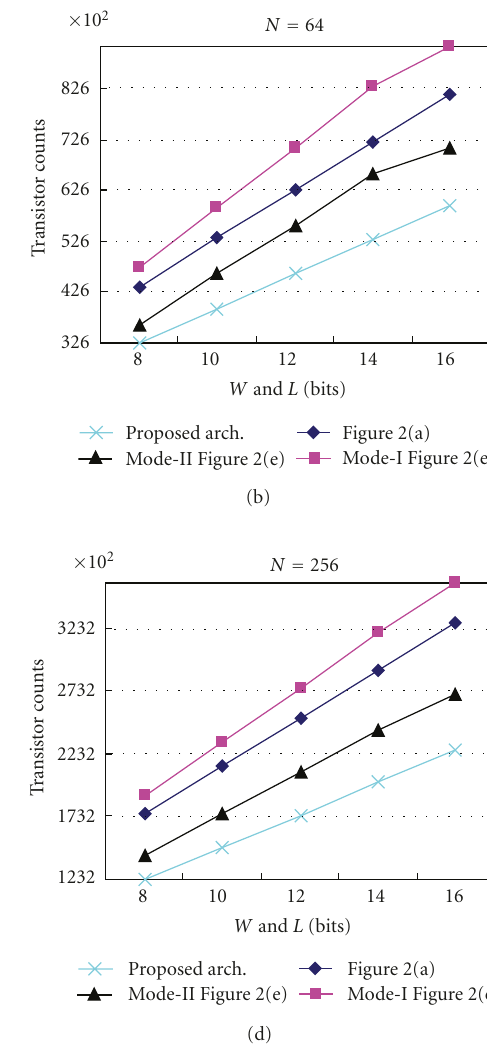
architecture in Figure 2(a), the folding number is W/ 2, which would derive at a critical delay of 4 T FA according to